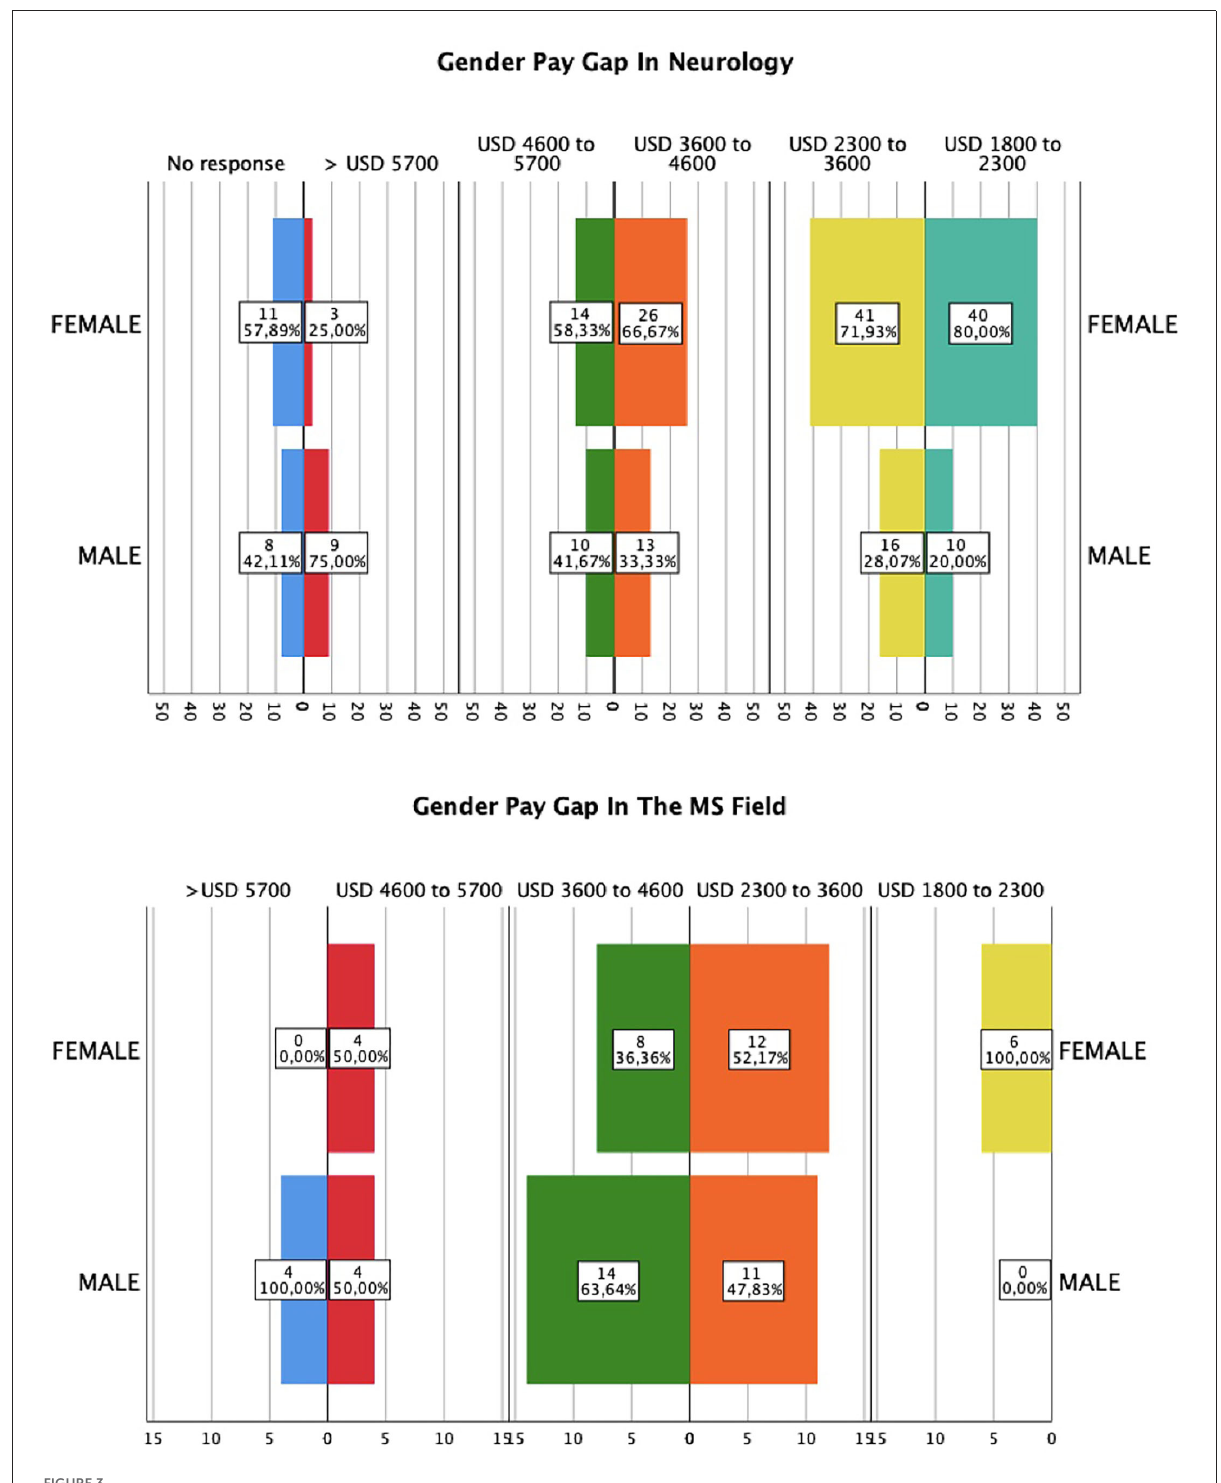
FIGURE3 Gender pay gaps across neurology and MS field. Payment was calculated by monthly income. USD, U.S